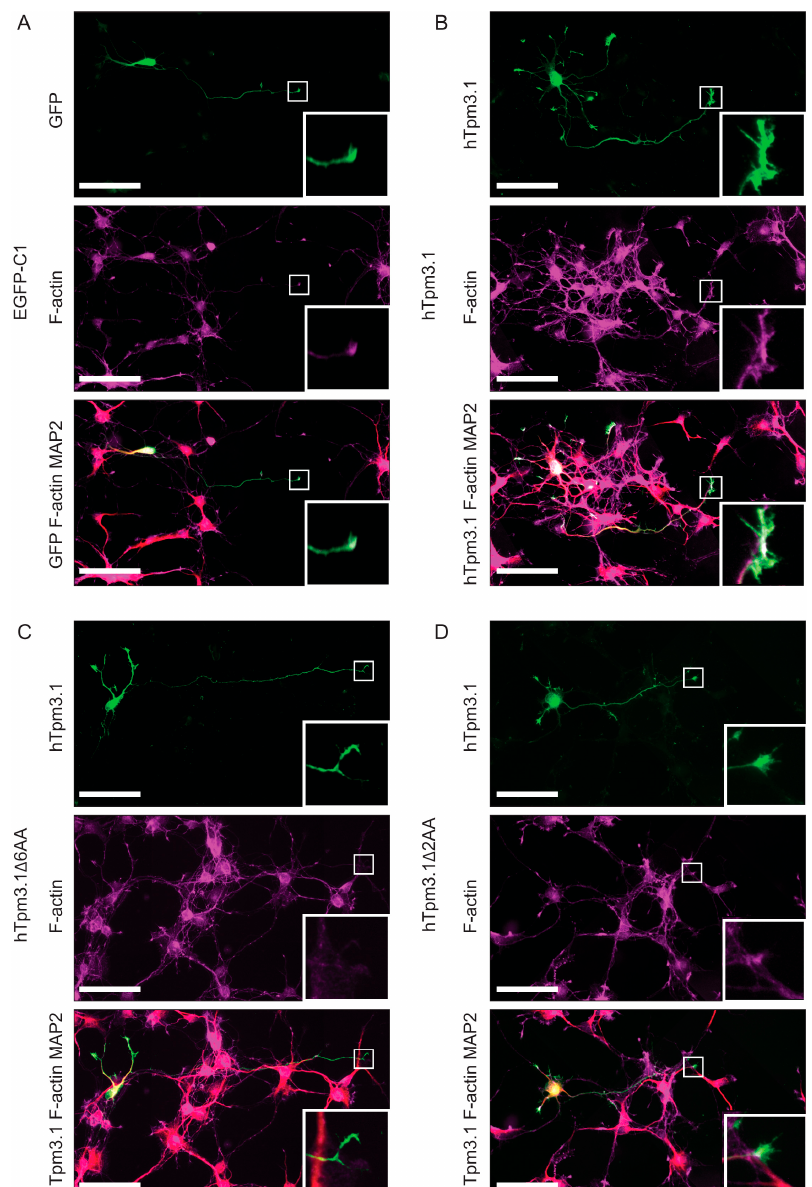
Figure 8. Effects of hTpm3.1 C-terminal truncation on the amount of F-actin pool in the growth cone of 3DIV old mouse primary hippocampal neurons. Representative fluorescent images of